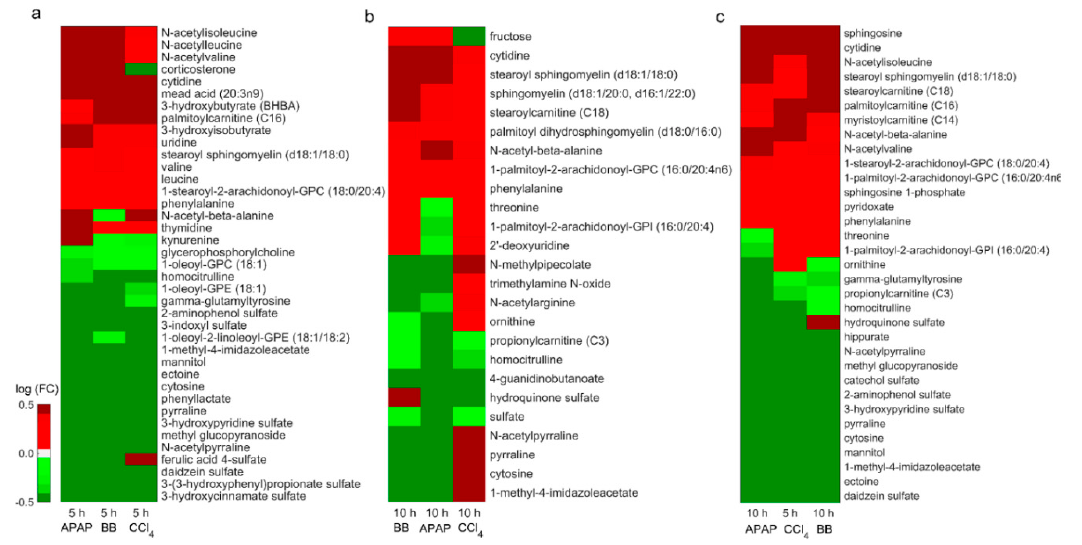
Figure 6. A heat map of significantly altered plasma metabolites (FDR < 0.1) that were common to APAP, BB, and CCl 4 exposures ( a ) at the 5 h time point, ( b ) at the 10 h time point, and ( c ) based on time points at which we observed maximum correlation. Red and green bars indicate elevated and decreased metabolite levels, respectively.